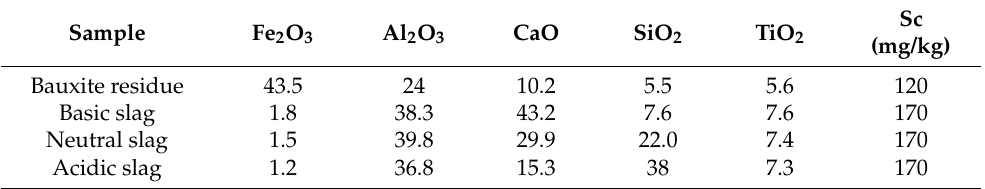
Table 2. Chemical composition of red mud and the slag samples from reduction smelting analyzed by [59], wt.%. (reproduced from Ref.